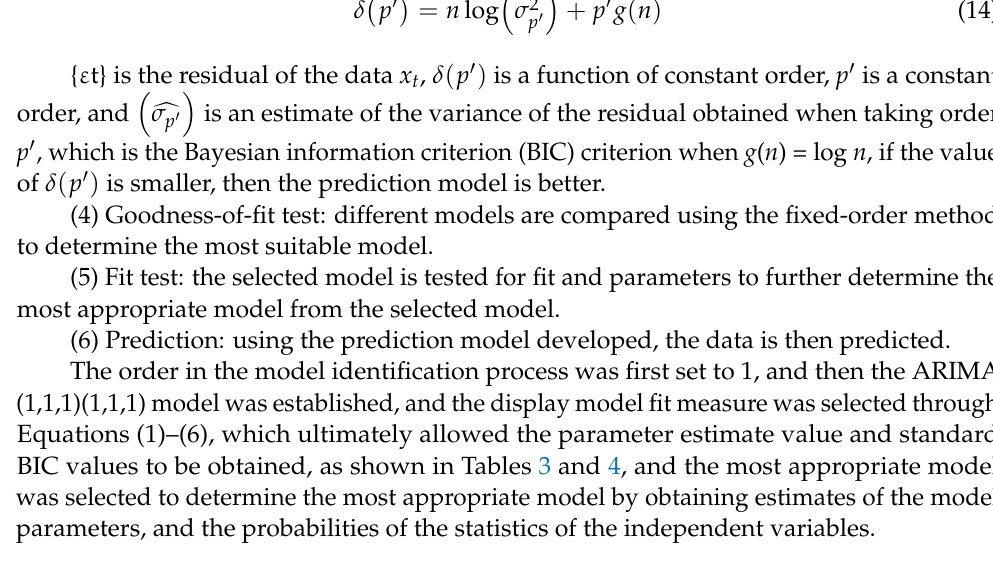
Table 3. Statistics of the parameter estimate value and probability of the data statistic for ARIMA (1,1,1)(1,1,1)